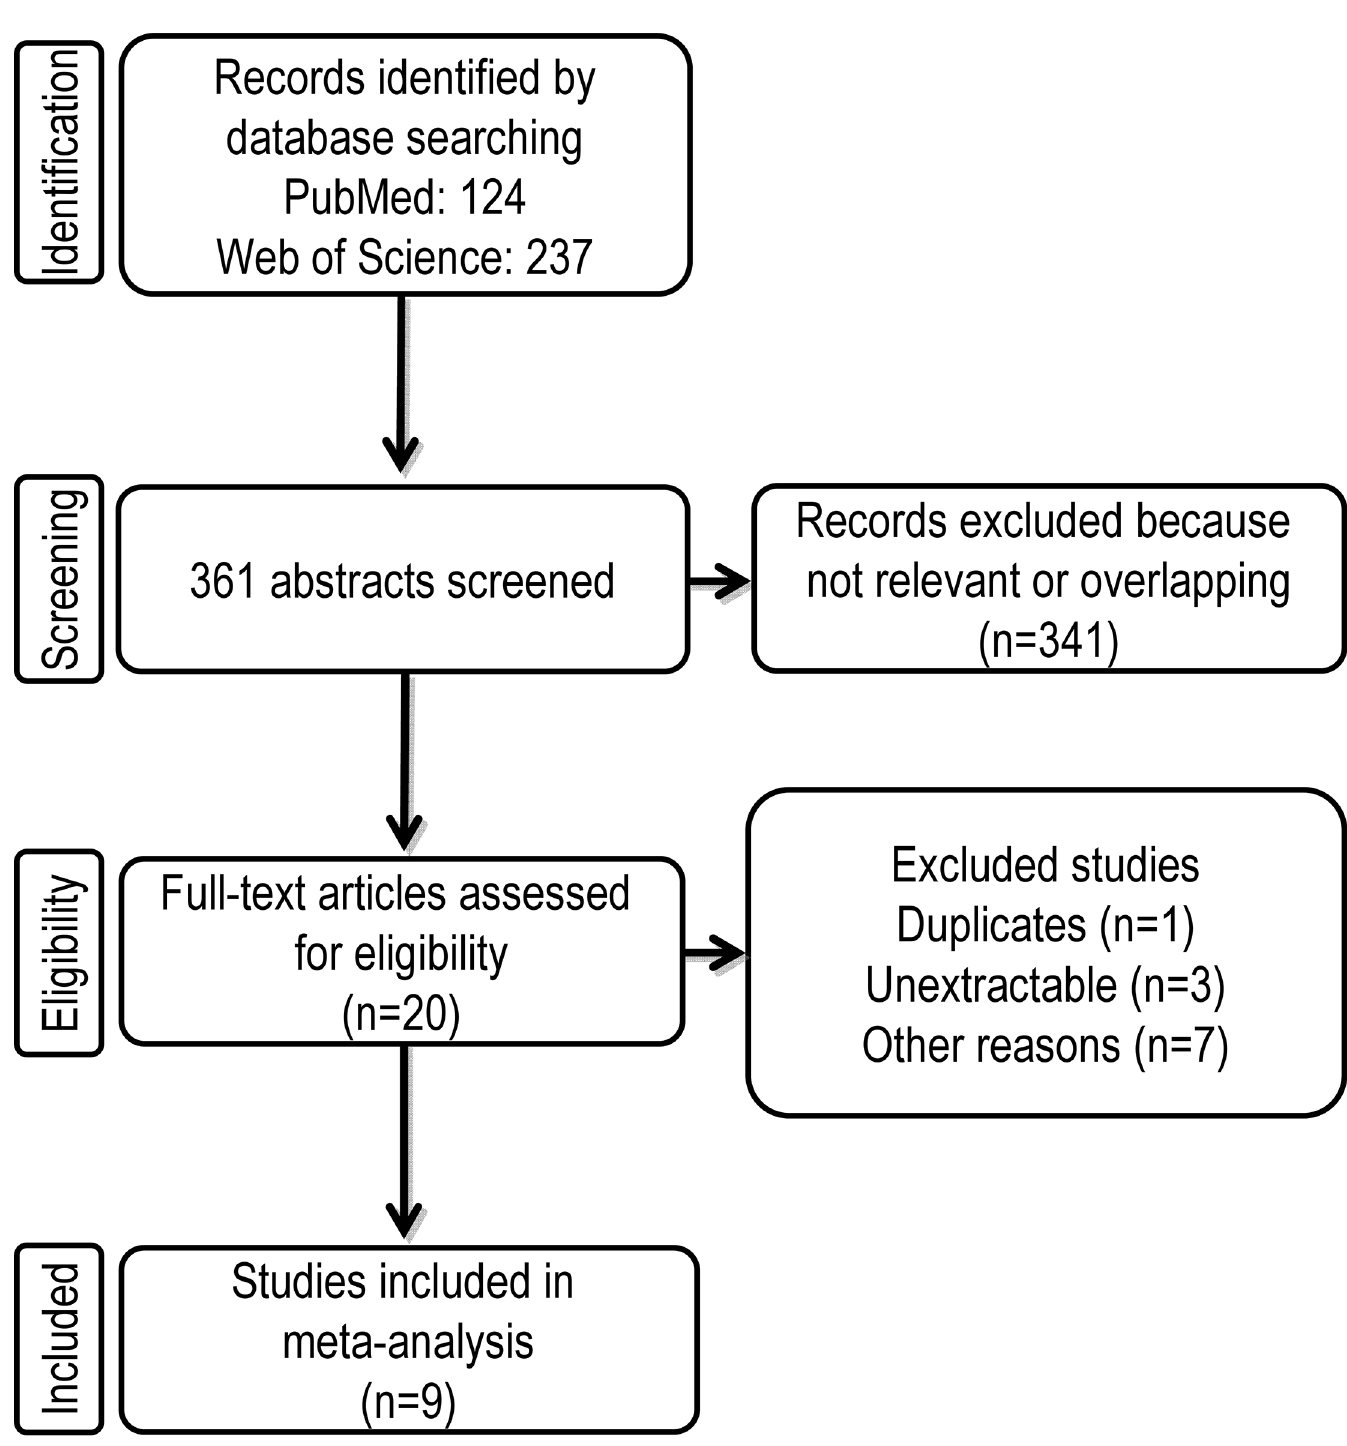
Fig 1. Flow chart summarizing the process of literature search and study